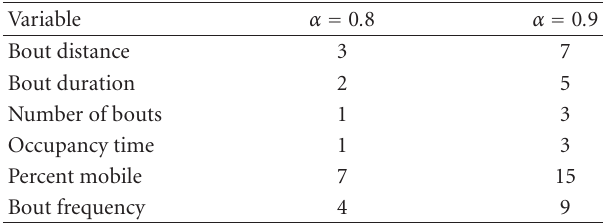
Table 6: Number of days needed for desired levels of reliability ( α ) di ff ered across variables.